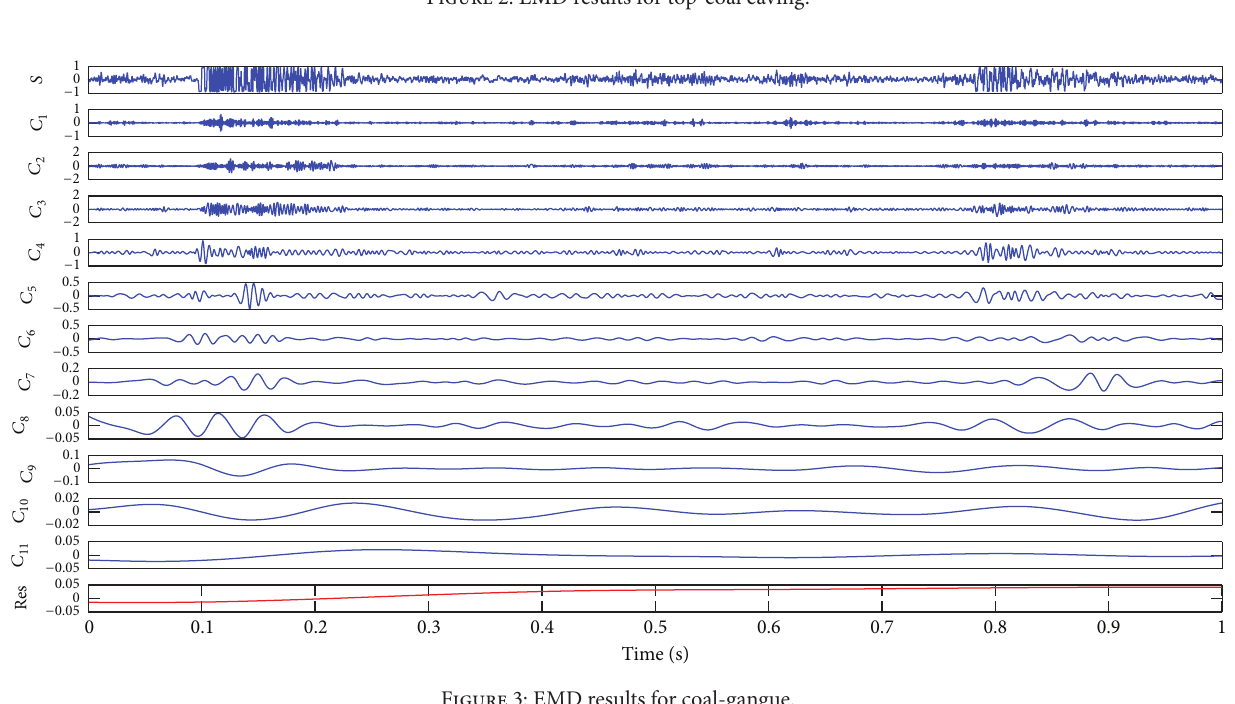
Figure 2: EMD results for top-coal caving.